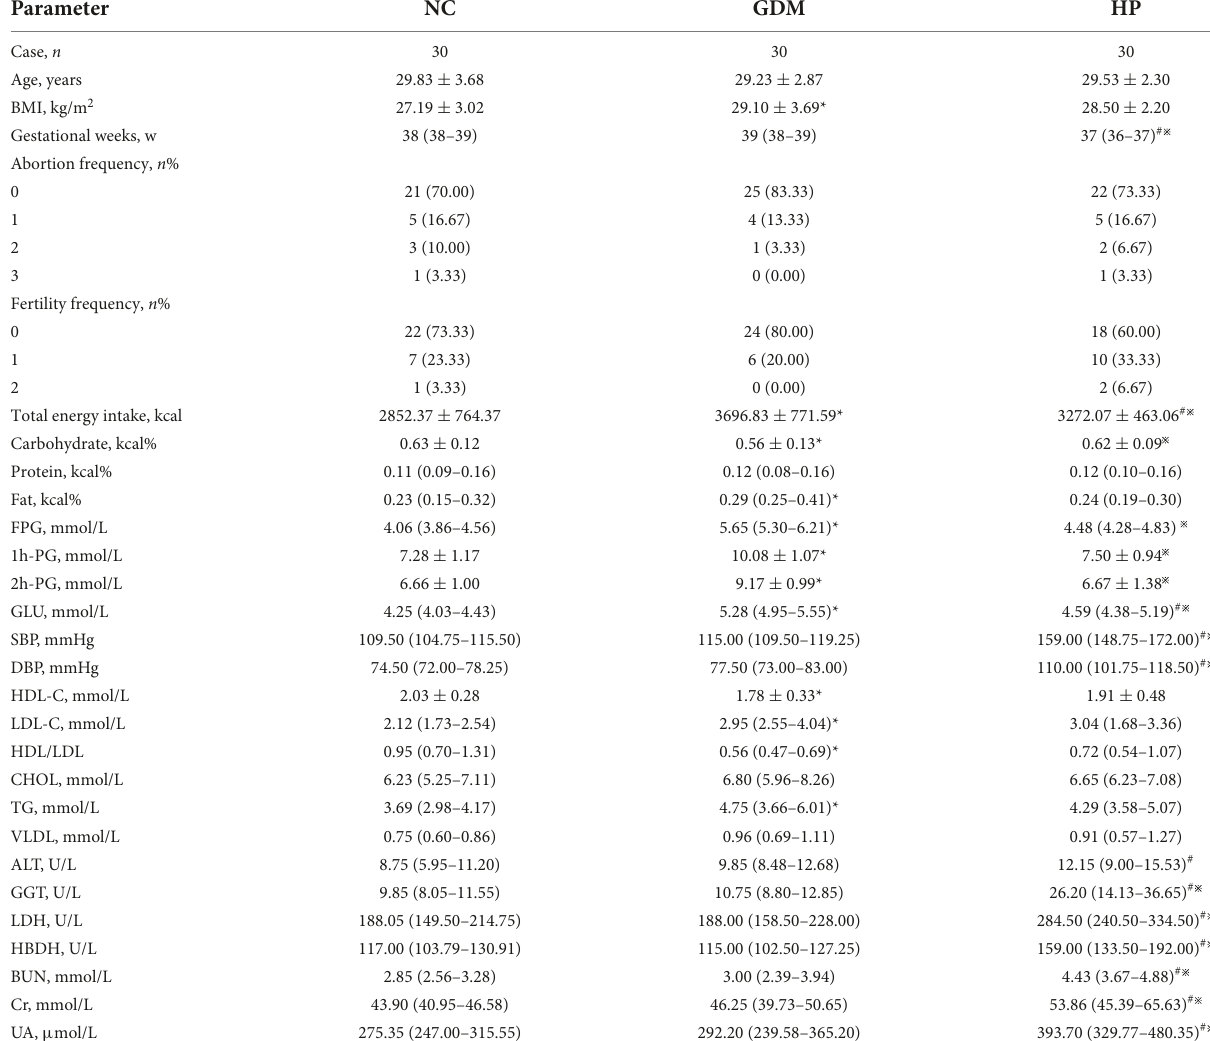
TABLE 1 Anthropometric and clinical characteristics of 90